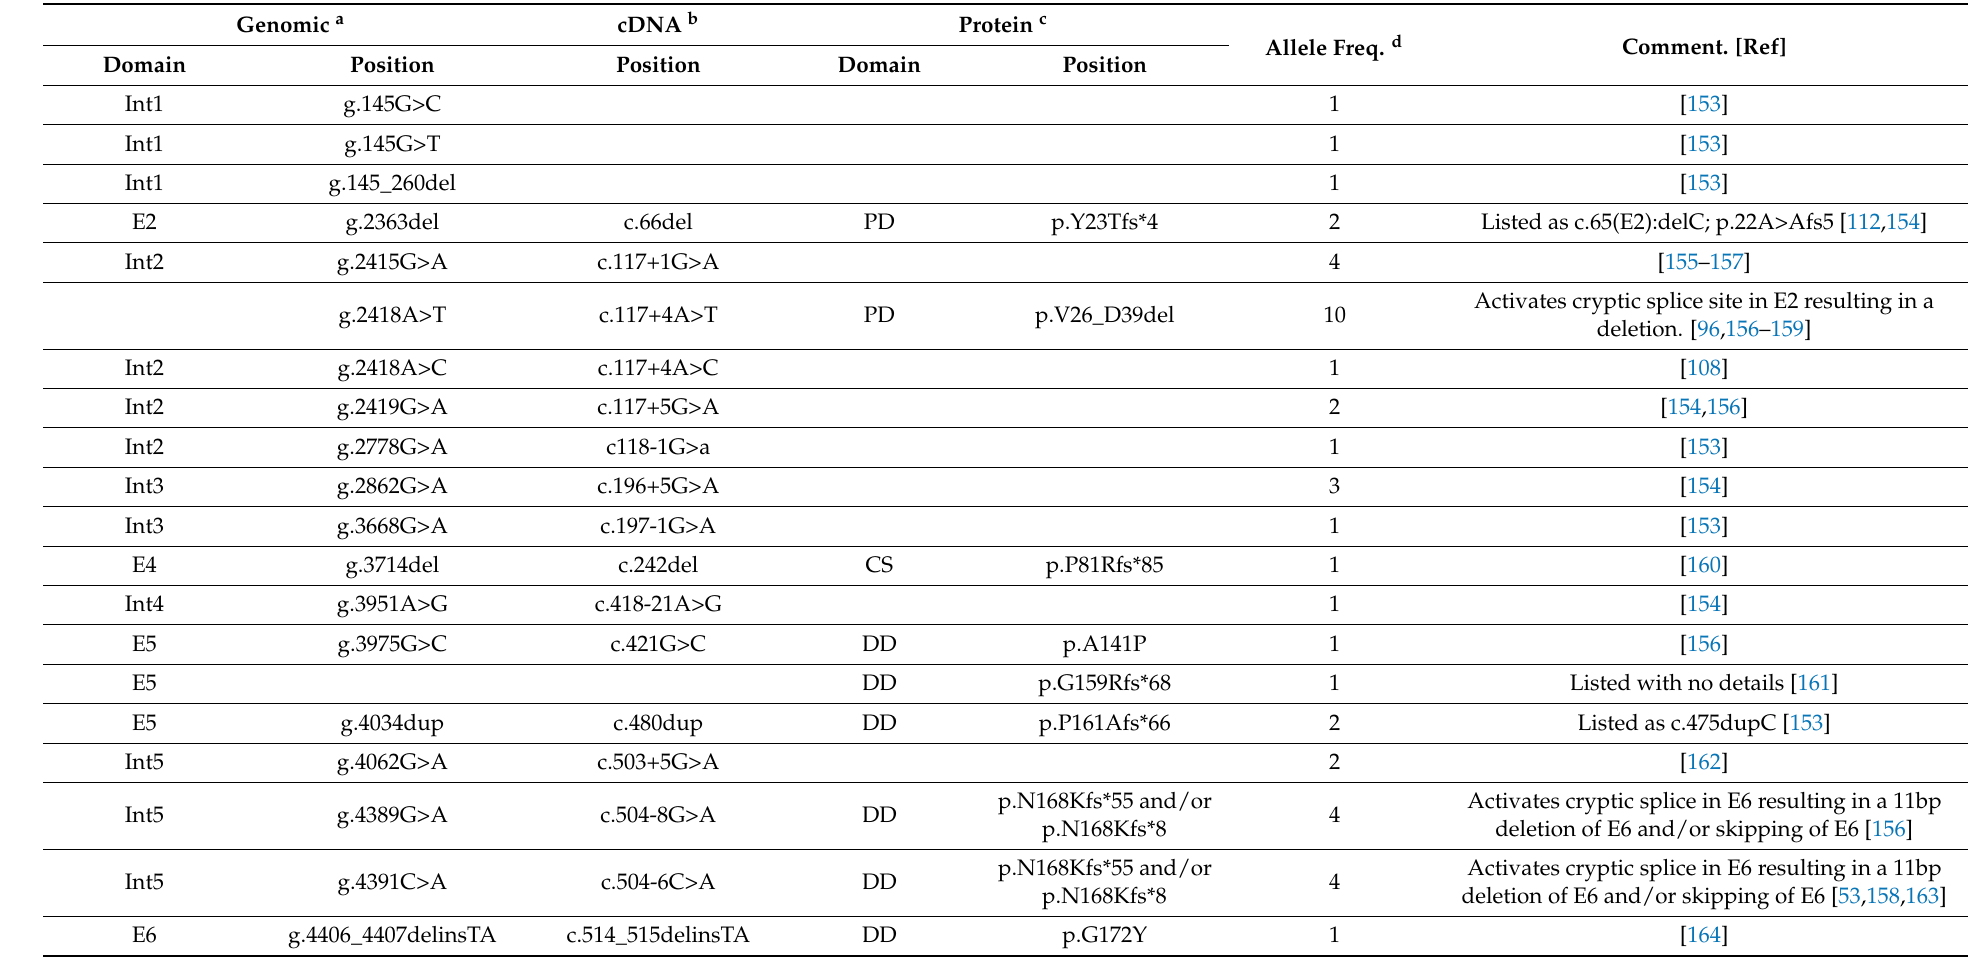
Table 2. Summary of the described TCIRG1 mutations in osteopetrotic